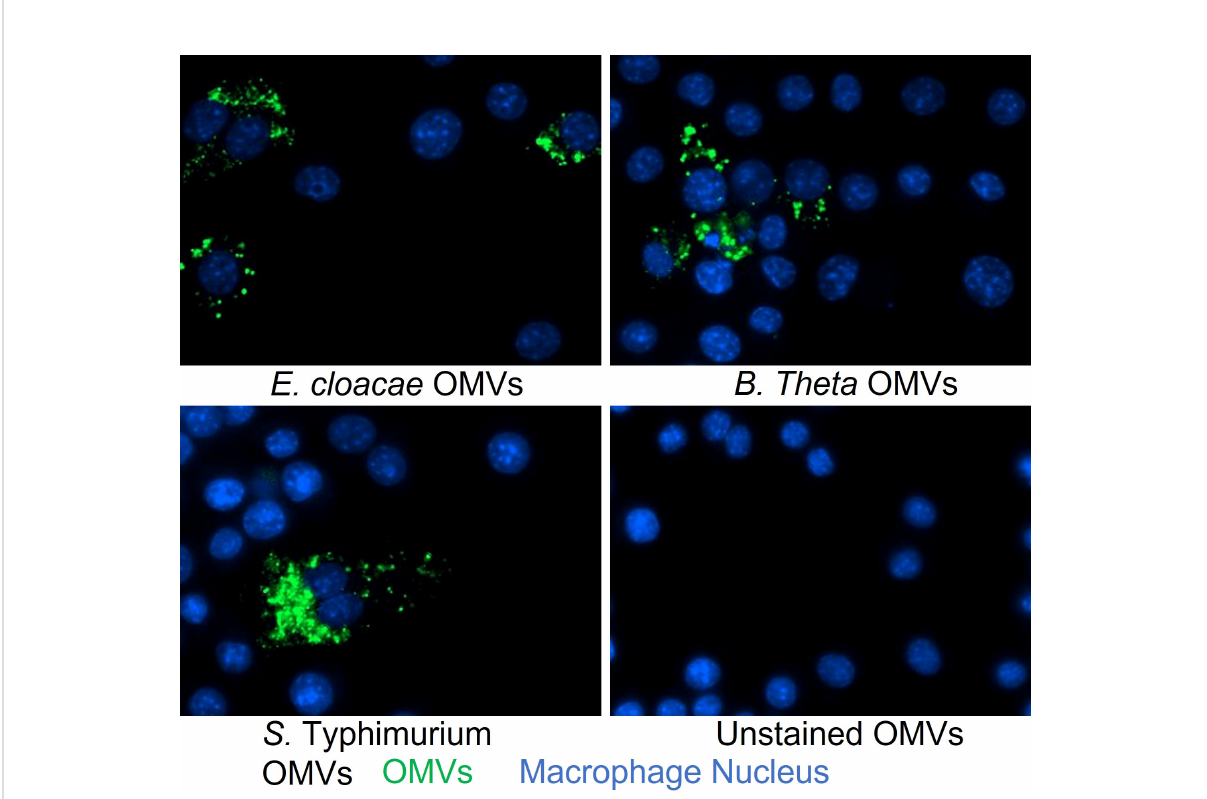
FIGURE 3 Analysis of OMVs uptake into macrophages at 1 hr post-inoculation. OMVs derived from E cloacae , B thetaiotaomicron , or S. Typhimurium were stained with DiO, inoculated onto RAW264.7 cells, and incubated at 37°C for 1 hr. The cells were washed and stained with DAPI during fi xation and then visualized using the Cytation 5 multiplate reader equipped with a fl uorescent microscope at a 20x magni fi cation. Untreated control showed only DAPI staining of the nucleus (blue), whereas the OMV treated wells showed the presence of OMVs (green) surrounding the nucleus, suggesting the presence of OMVs in the